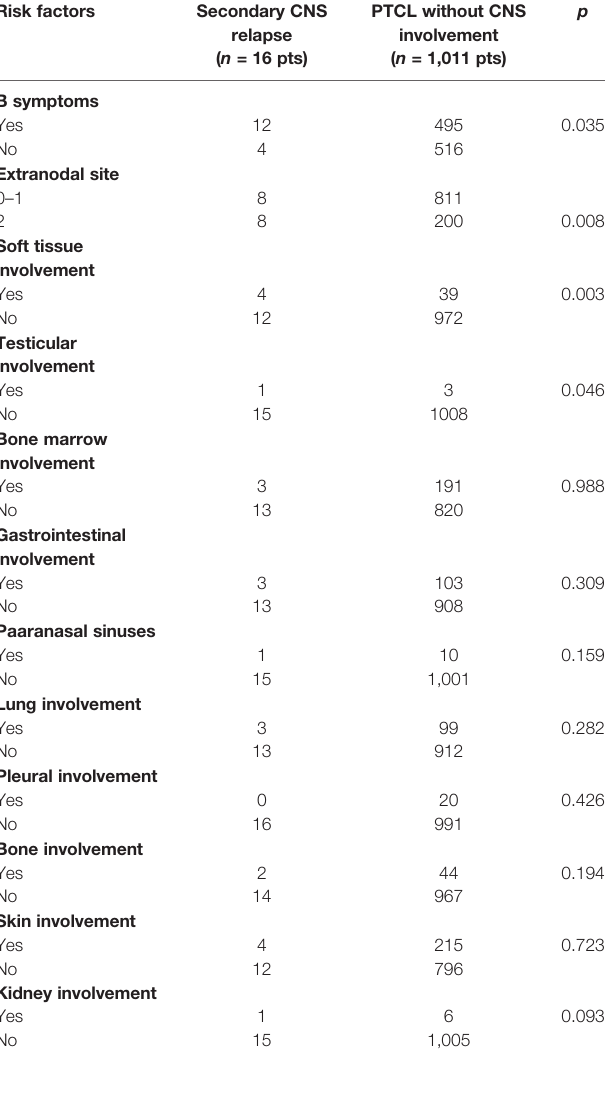
TABLE 5 | Risk factors for secondary CNS relapse in peripheral T-cell lymphomas.